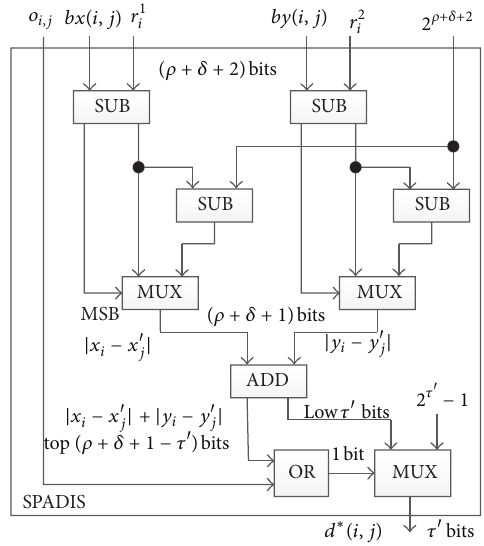
Figure 5: Structure of SPADIS for city block